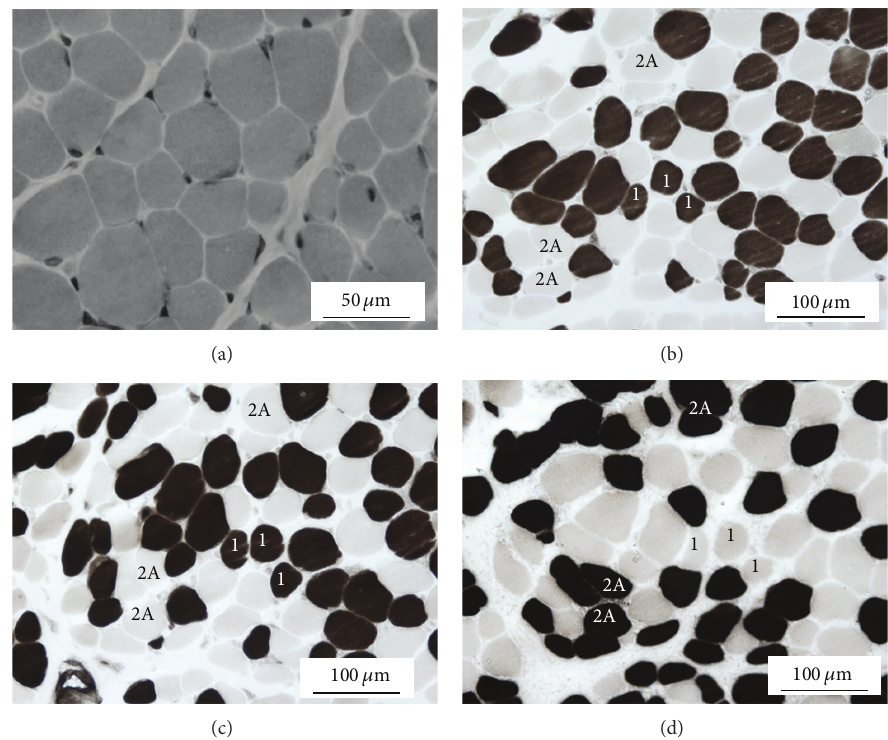
Figure 1: Cryostat sections of the patient’s muscle biopsy. (a) Hematoxylin and eosin staining reveals clear variations in myofiber size. (b), (c), and (d) ATPase staining at 4.2 (b), 4.6 (c), and 11 (d). The “1” and “2A” in the figure denote type 1 and 2A fibers, respectively. The findings indicate that type 1 fibers were 12% smaller than type 2 fibers, while type 2B fibers were